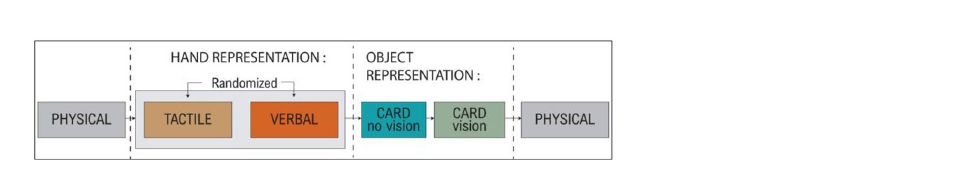
Figure 1. ( A ) Schematic top-view of the set up used for assessing body representation. The left hand of the participant is positioned under the graphic tablet while they pointed with eyes closed to a target—nail or metacarpophalangeal joint (MCP)—indicated by the experimenter using the stylus pen (without somatosensory or visual feedback). ( B ) Picture of the device.